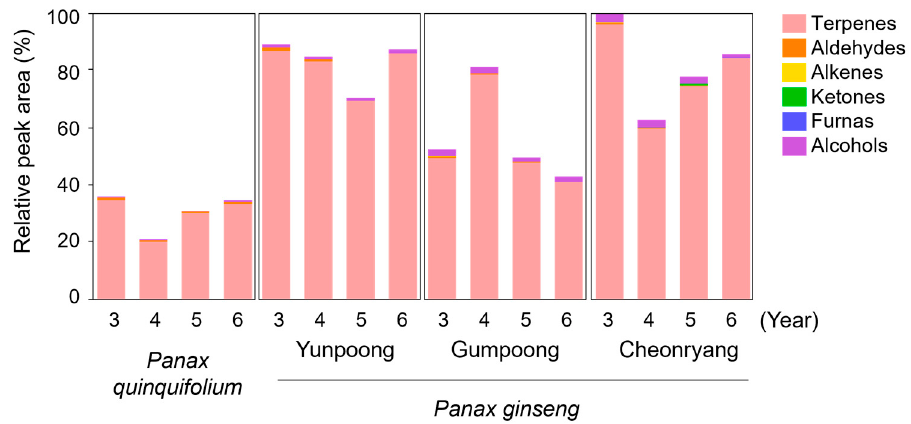
Figure 1. Profiles of volatile compounds present in the four different white ginseng roots grown for 3–6 years. The concentrations of volatile compounds are relatively indicated as percentages based on the total peak area (100) in the 3-year-old ‘Cheonryang’ cultivar. Data are provided as mean values ( n = 3 biological replicates).